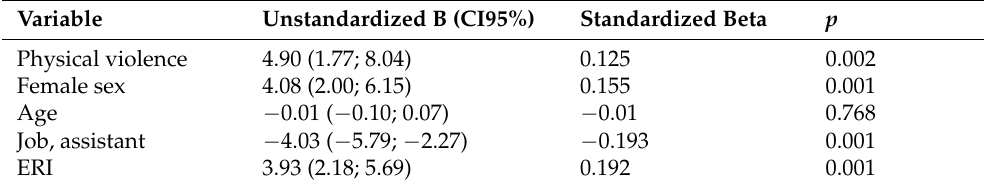
Table 4. Association of physical violence with headaches. Multiple linear regression analysis.